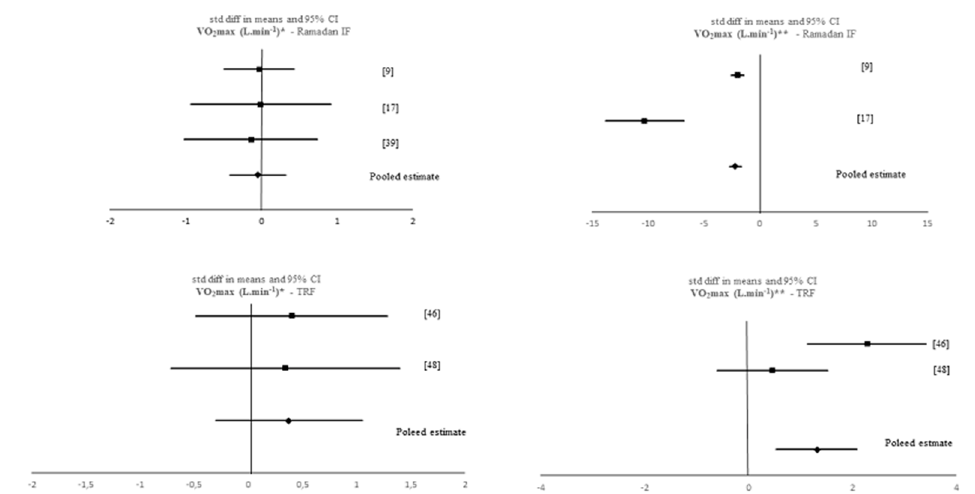
Figure 2. Forest plot of the effects from a fixed-effects meta-analysis shown as standardized mean difference with 95% confidence intervals on maximum oxygen uptake (VO 2max ) only Ramadan IF studies and only TRF studies. For each study, the square represents the standardized mean difference between pre- and post-intervention time points and, whenever possible, between pre- post-data of both intervention and control groups with the horizontal line intersecting it as the lower and upper limits of the 95% confidence interval. The rhombi represents the pooled estimated standardized mean difference. Note. * Pre-post tests, IF intervention; ** Pre-post tests, IF intervention vs. control.